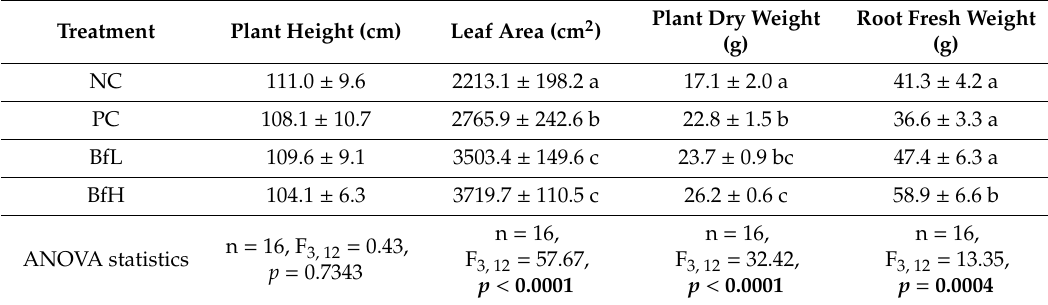
Table 3. Plant morphology parameters at 48 days after inoculation (DAI) in di ff erent treatments in the pot